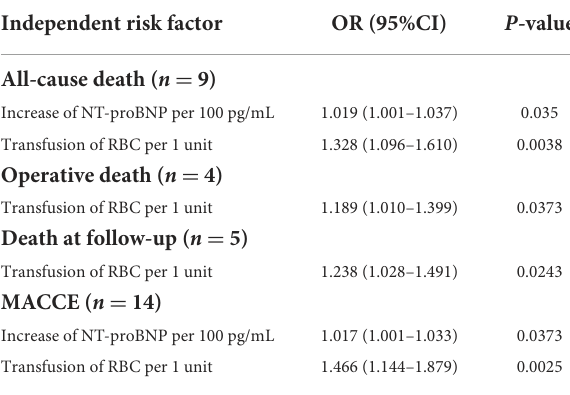
TABLE 2 Independent risk factors for